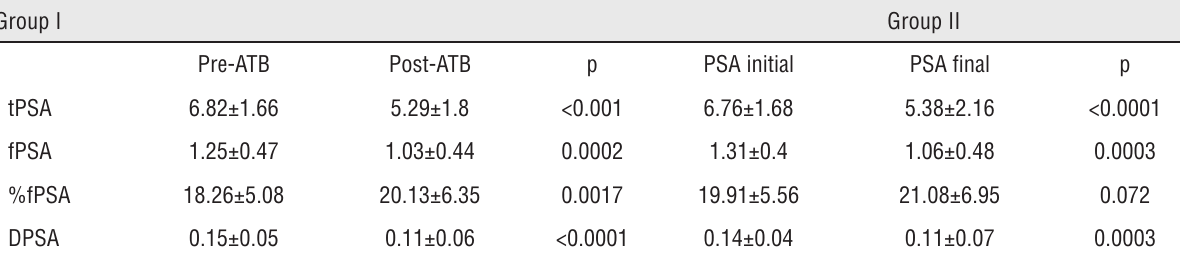
Table 2 - Comparison of initial and final PSA values between groups. Group I Group II Pre-ATB Post-ATB p PSA initial PSA